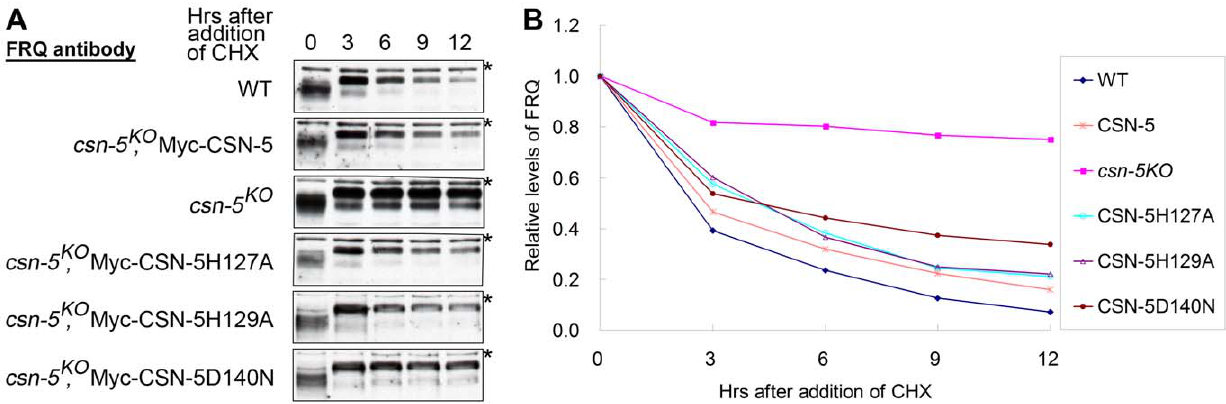
Figure 4. Mutations in the JAMM motif of CSN-5 partially restore SCF-mediated FRQ degradation in the csn-5 KO strain. (A) Western blot analyses showing degradation of FRQ protein in csn-5 mutant and the different CSN-5 complementation strains after addition of cycloheximide (10 mg/mL). Asterisks indicate nonspecific bands detected by FRQ antibody. (B) Densitometric analyses from four independent experiments showing the degradation of FRQ in different